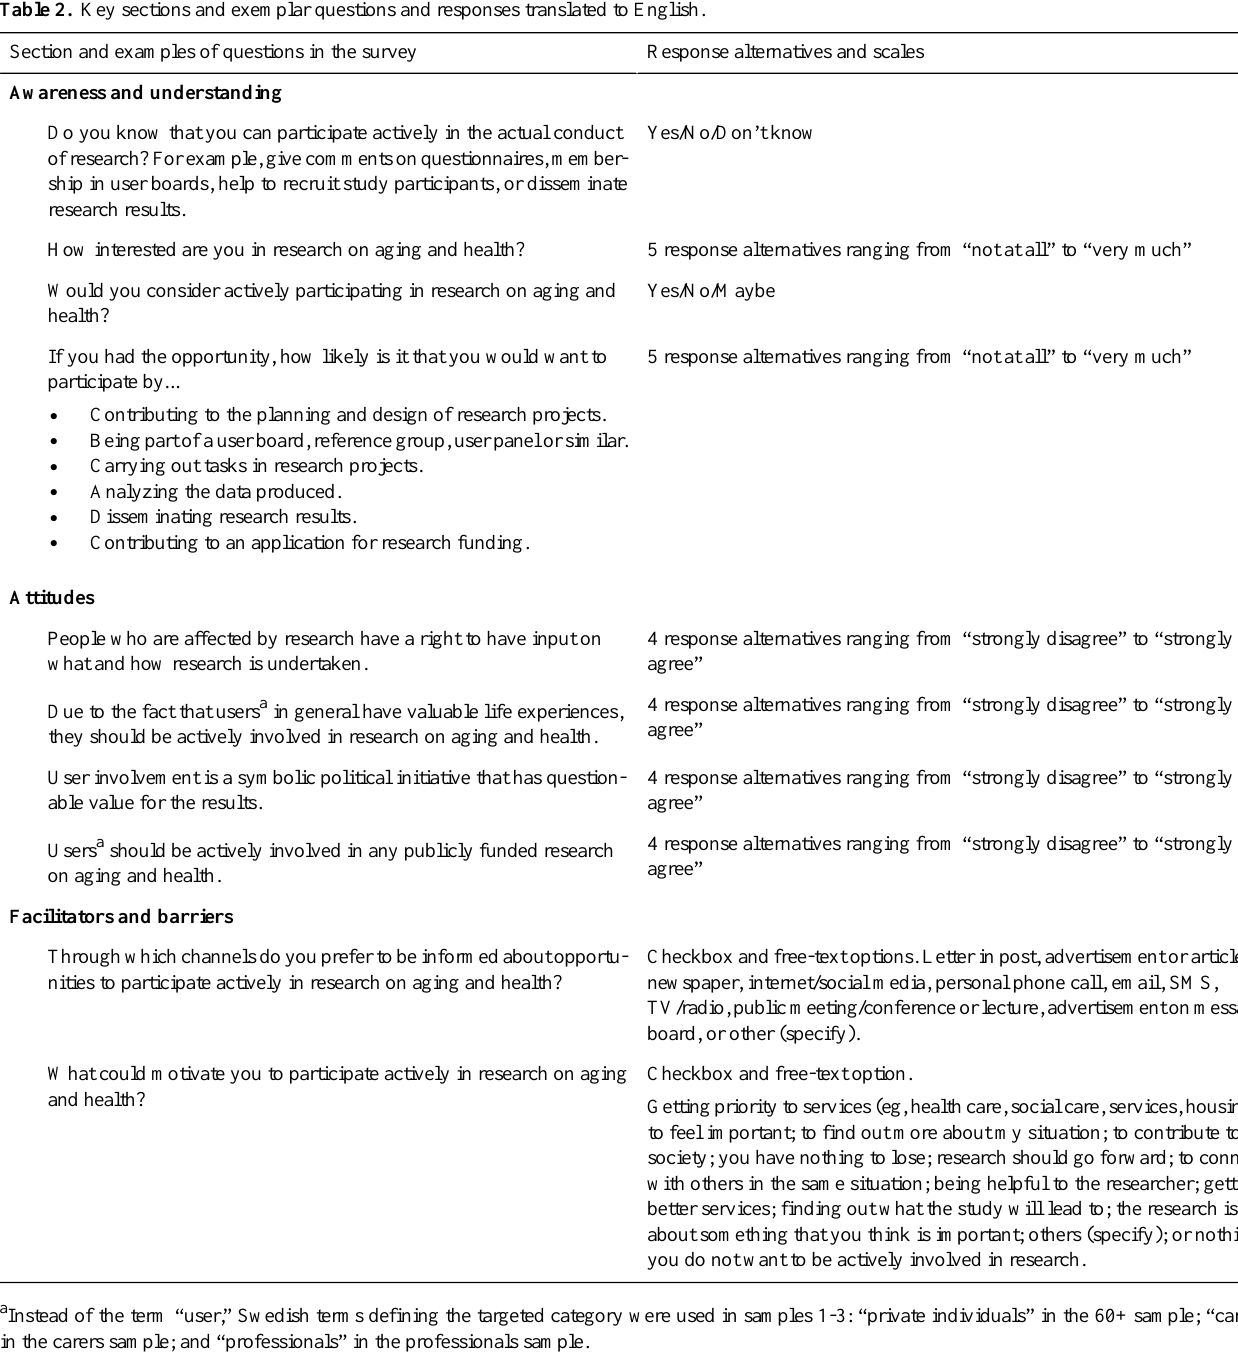
Table 2. Key sections and exemplar questions and responses translated to English. Awareness and